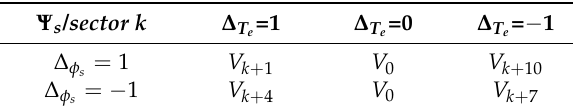
Table 1. ST of conventional DTC.